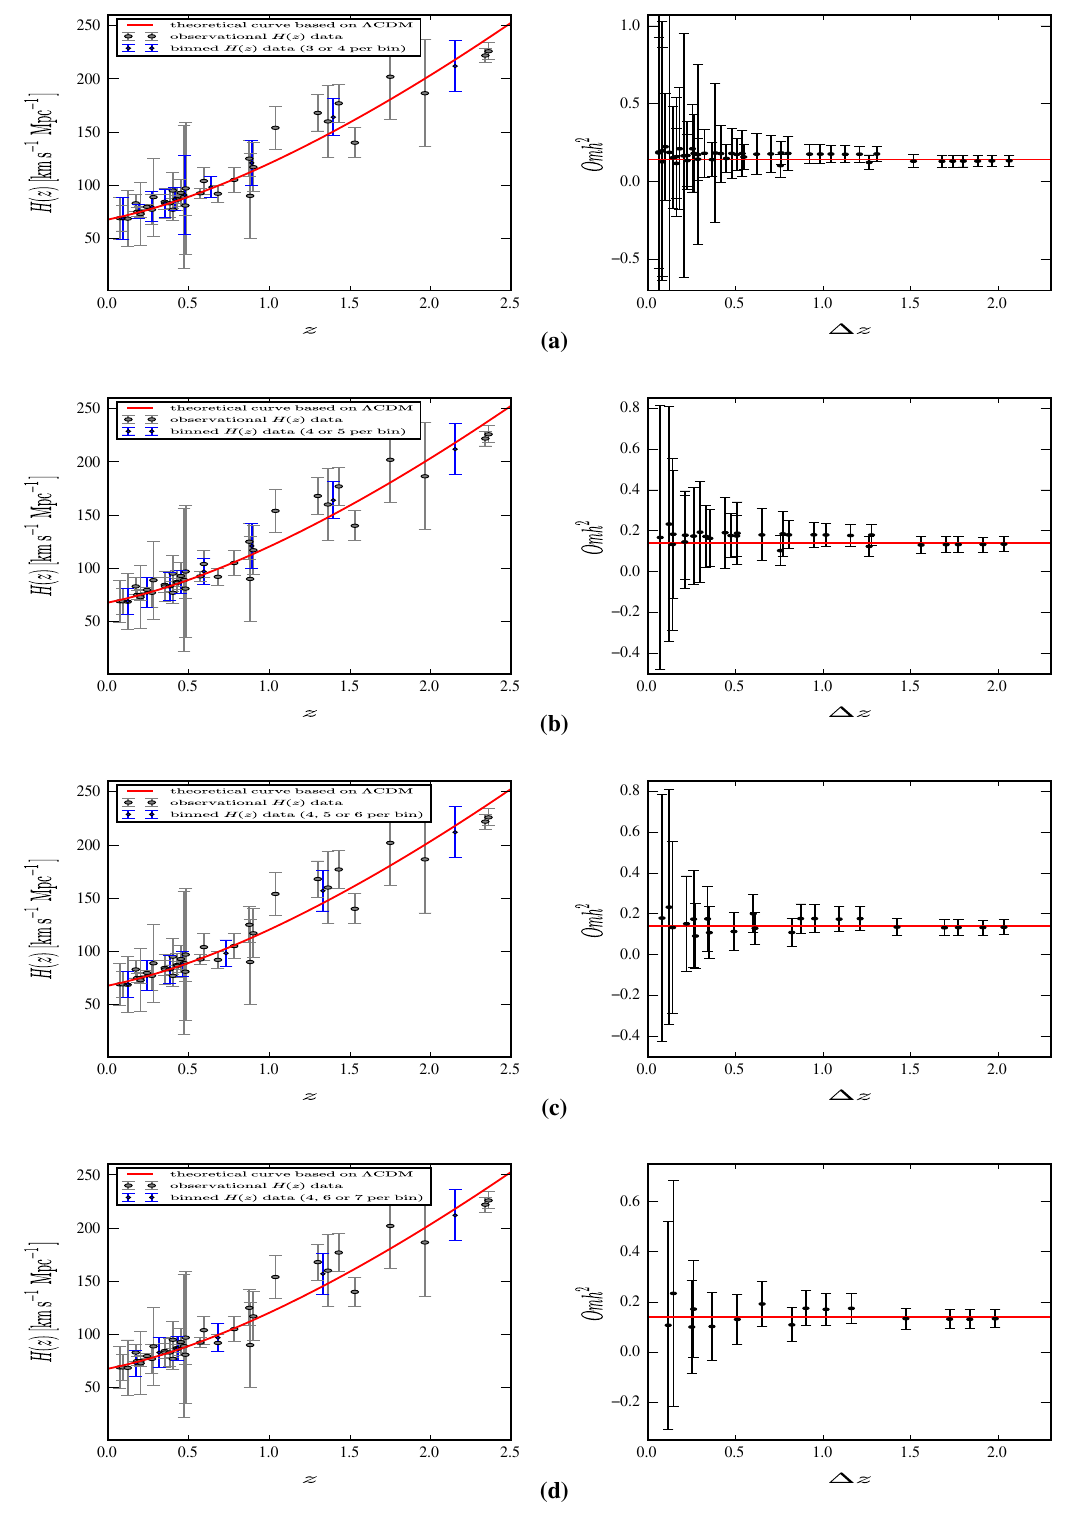
Fig. 3 37 reduced OHD associated with binned data and its corre- sponding Omh 2 diagnostic values for the median statistics technique. The panels a – d present the 3–4, 4–5, 4–5–6 and 4–6–7 measurements